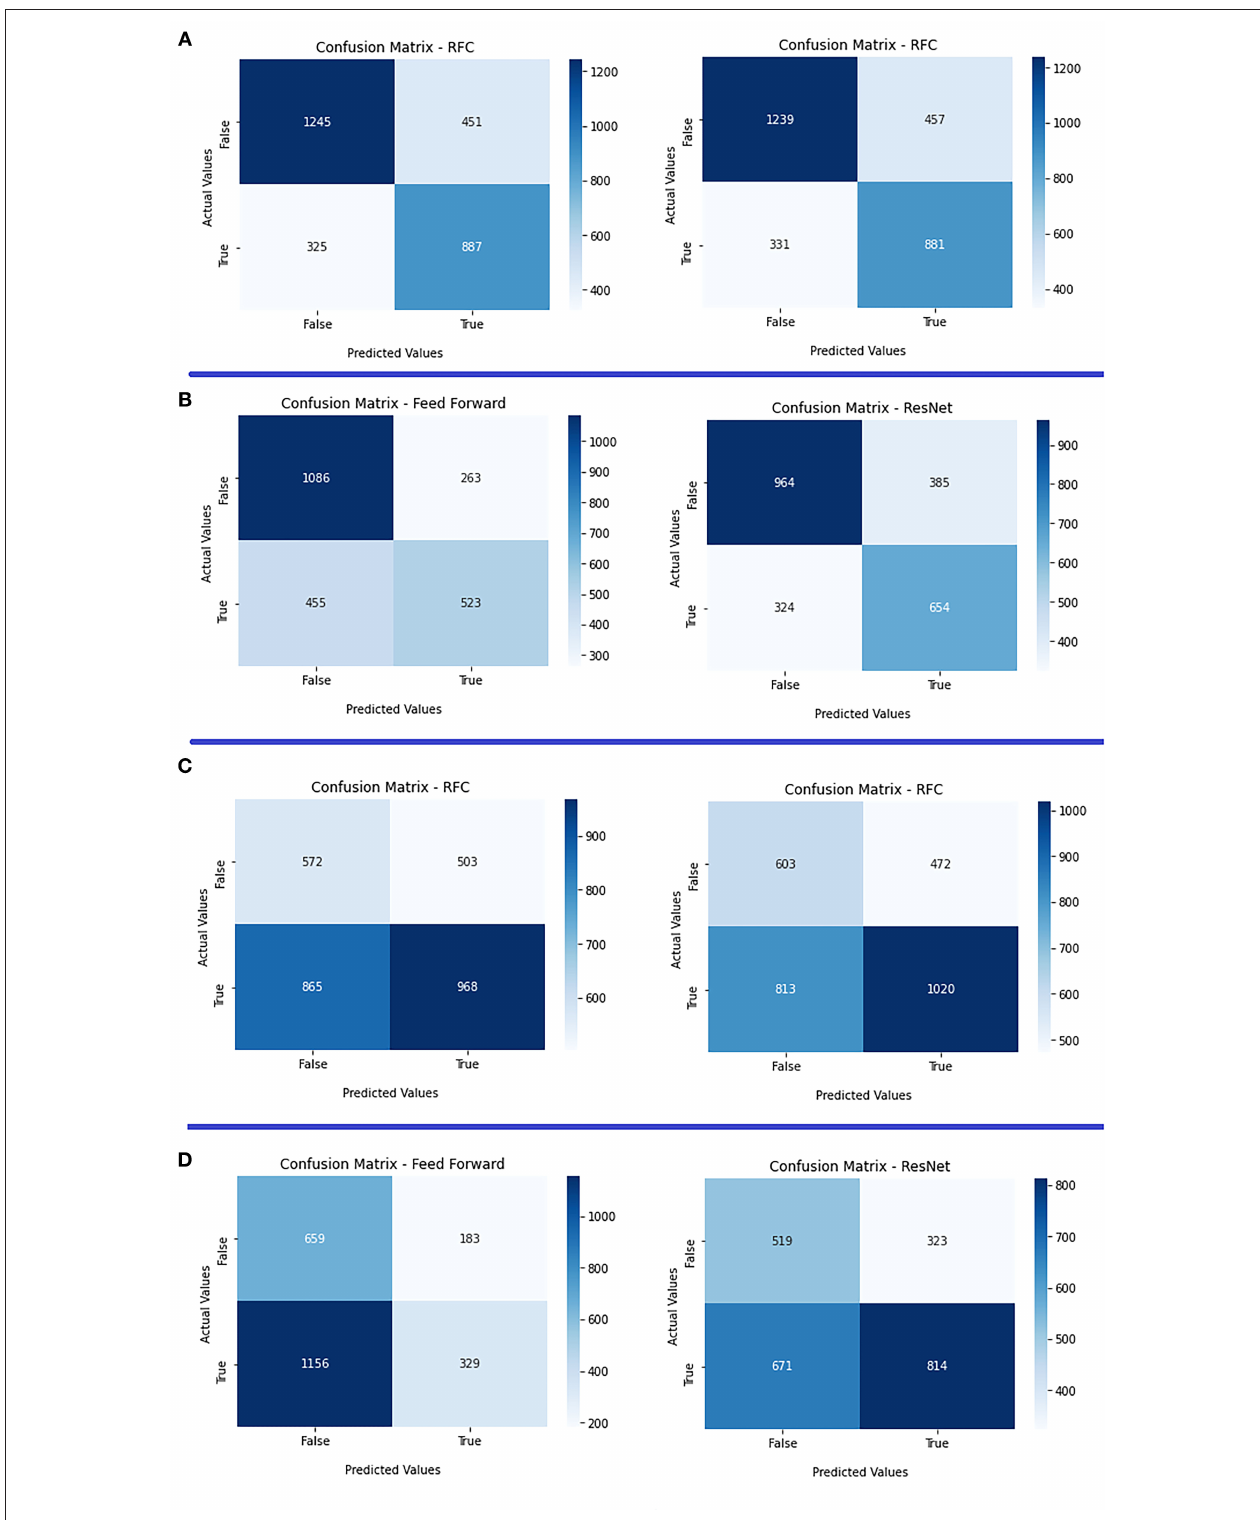
FIGURE 4 | Confusion matrices of both radiomics and deep learning approaches. (A) Clinical experiment (left) vs. combination (right) for mRs prediction using the radiomics approach; (B) clinical experiment (left) vs. combination (right) for mRs prediction using the deep learning approach; (C) clinical experiment (left) vs. combination (right) for eTICI prediction using radiomics approach; and (D) clinical experiment (left) vs. combination (right) for eTICI prediction using the deep learning approach.